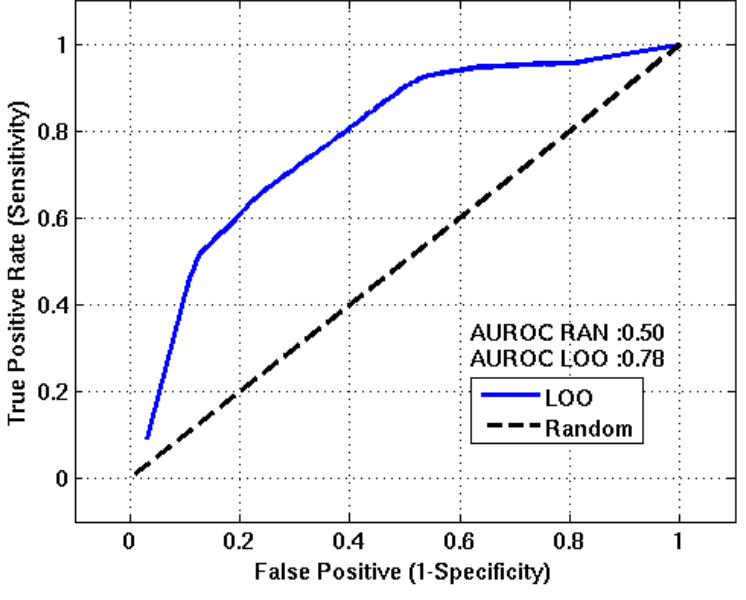
Figure 5. Receiver Operating Characteristics for the intrusion event tree node. The AUROC value of approximately 0.78 suggests this node will have fair to good predictive capabilities. TPR, FPR, accuracy, and precision estimates of 71%, 29%, 71% and 85% are obtained at the optimum detection threshold,